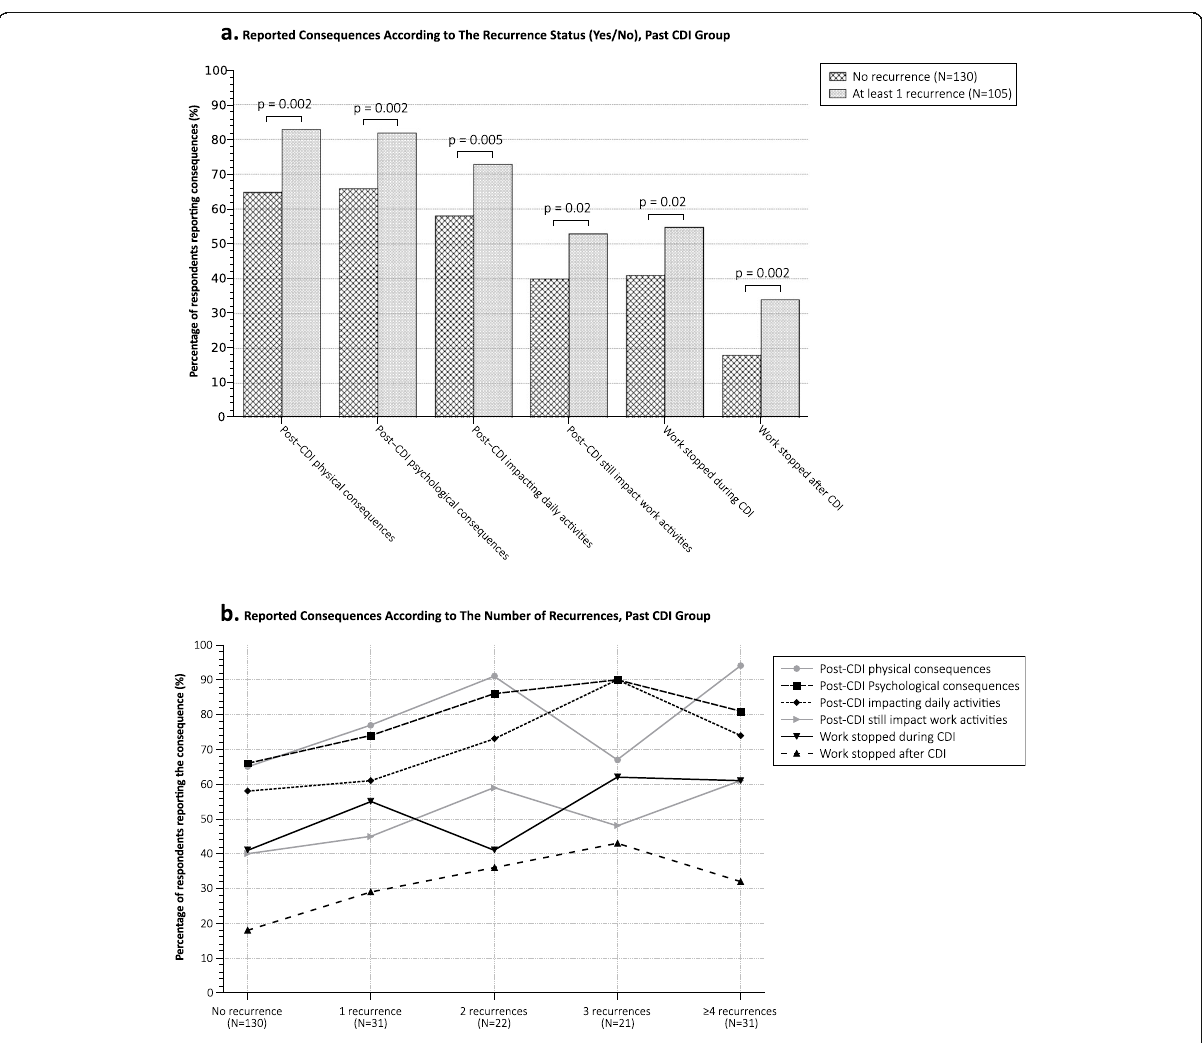
Fig. 3 Impact of recurrences on CDI consequences, Past CDI